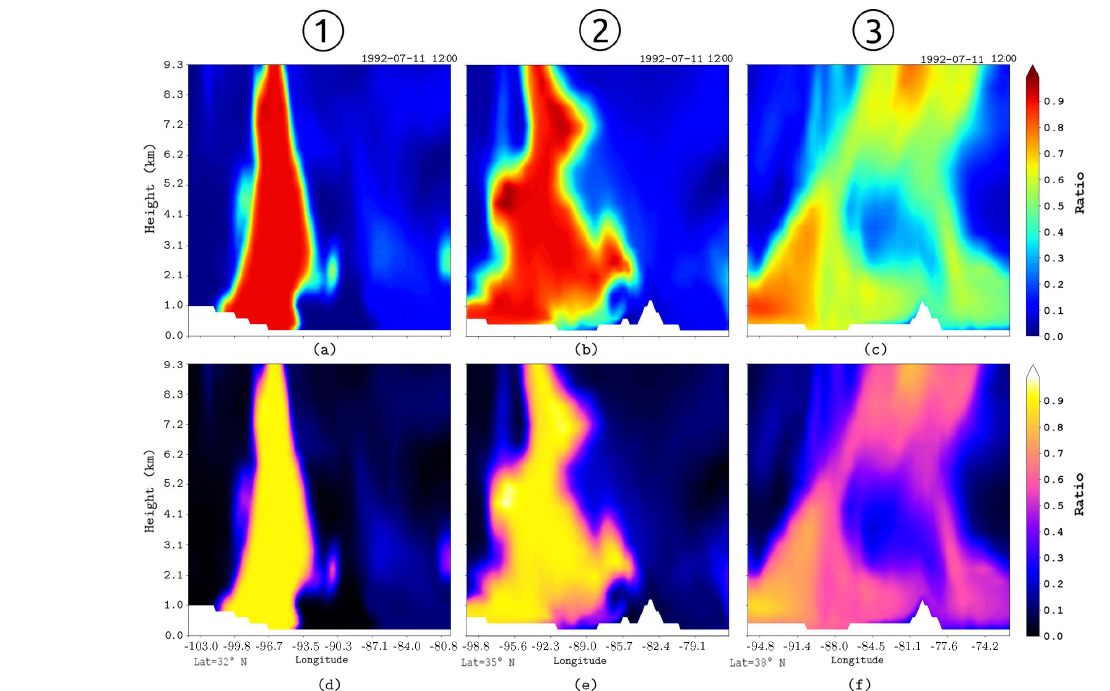
Figure 7. (a–c) Ratio of q TR : q for the three vertical cross sections at the locations depicted by white lines in Fig. 5. Panels (d–f) same as (a–c) but for a ratio of phi TR : phi.